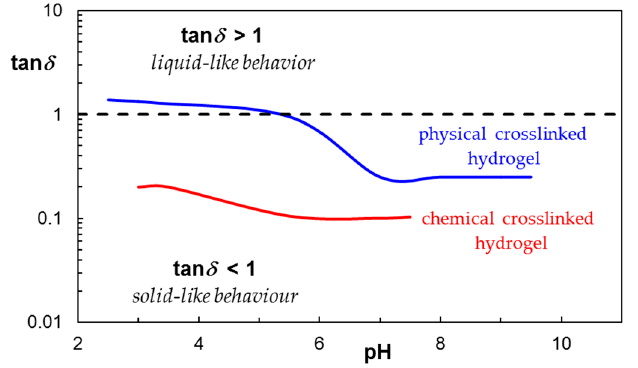
Figure 3. The loss tangent as a function of pH for CS/PVA/clay physical or chemical crosslinked hydrogel. (Adapted with permission from Ref. [132]. Copyright 2015, Elsevier).